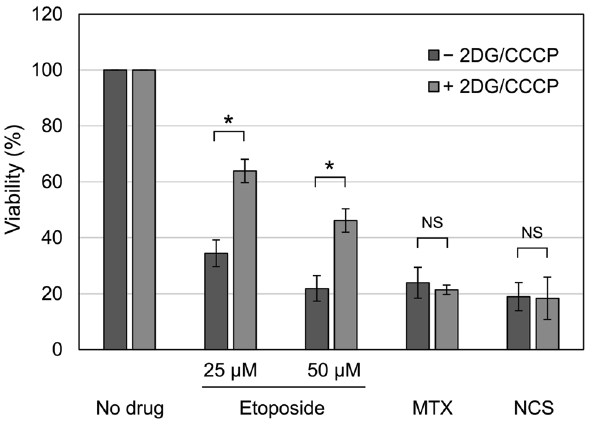
Figure 8. Etoposide is less effective in ATP-depleted cells. HeLa cells were treated with either 25 µM etoposide, 50 µM etoposide, 200 nM mitoxantrone (MTX), or 250 µg/ml neocarzinostatin (NCS) in the presence and absence of 25 mM 2DG/10 µM CCCP for 30 min. Cells were washed and incubated in medium without drugs for 3 days. Average values of viability and SD were calculated (n = 5). Statistical values are as follows; *: statistically significant, 25 µM etoposide p = 6.63E−06, 50 µM etoposide p = 2.11E−05. NS: Not significant, MTX p = 0.375, NCS p =